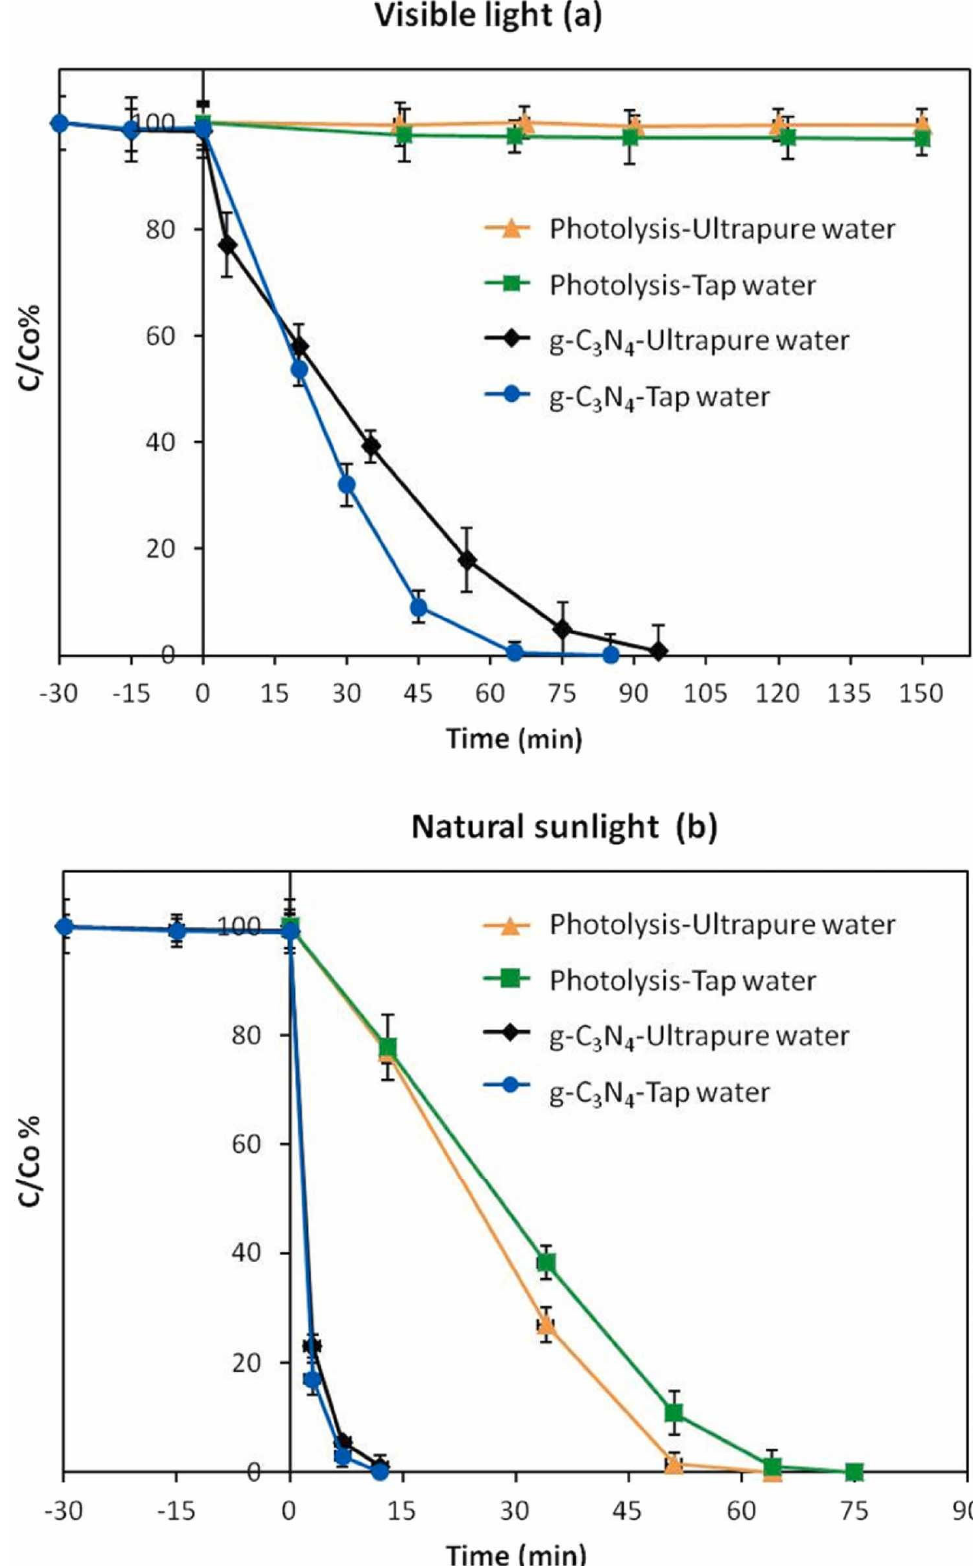
Figure 3. Photo-degradation of naproxen through g-C 3 N 4 under ( a ) visible light radiation, and ( b ) and natural sunlight. Reprinted/adapted with permission from [116], 2022, Elsevier (License Number